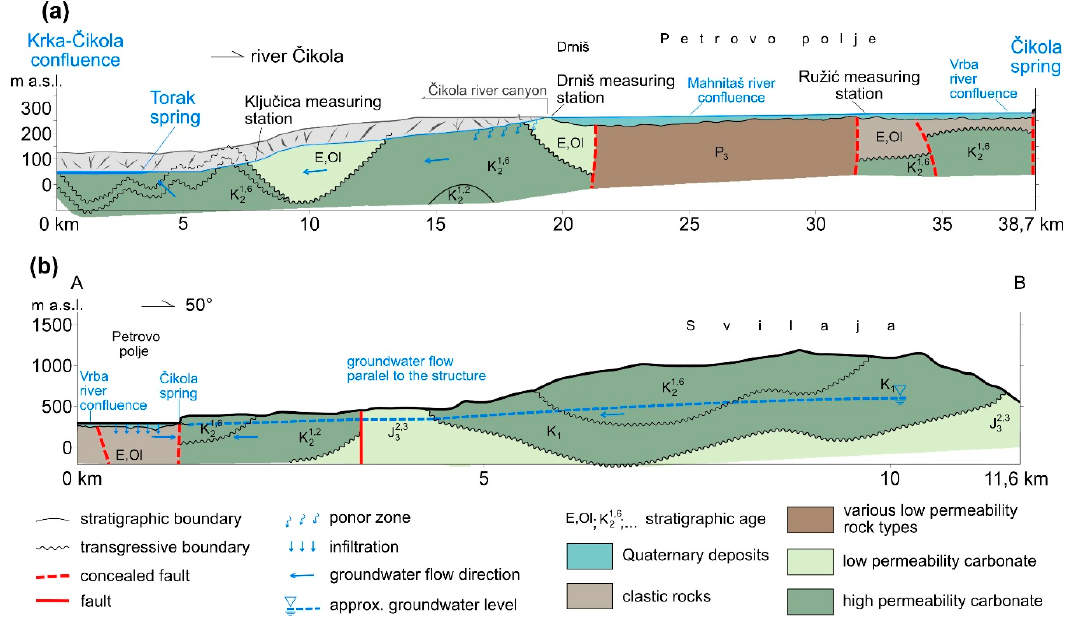
Figure 3. Hydrogeological and geomorphological profile of the Č ikola riverbed ( a ) and the spring’s catchment (( b ) modified after [35]).